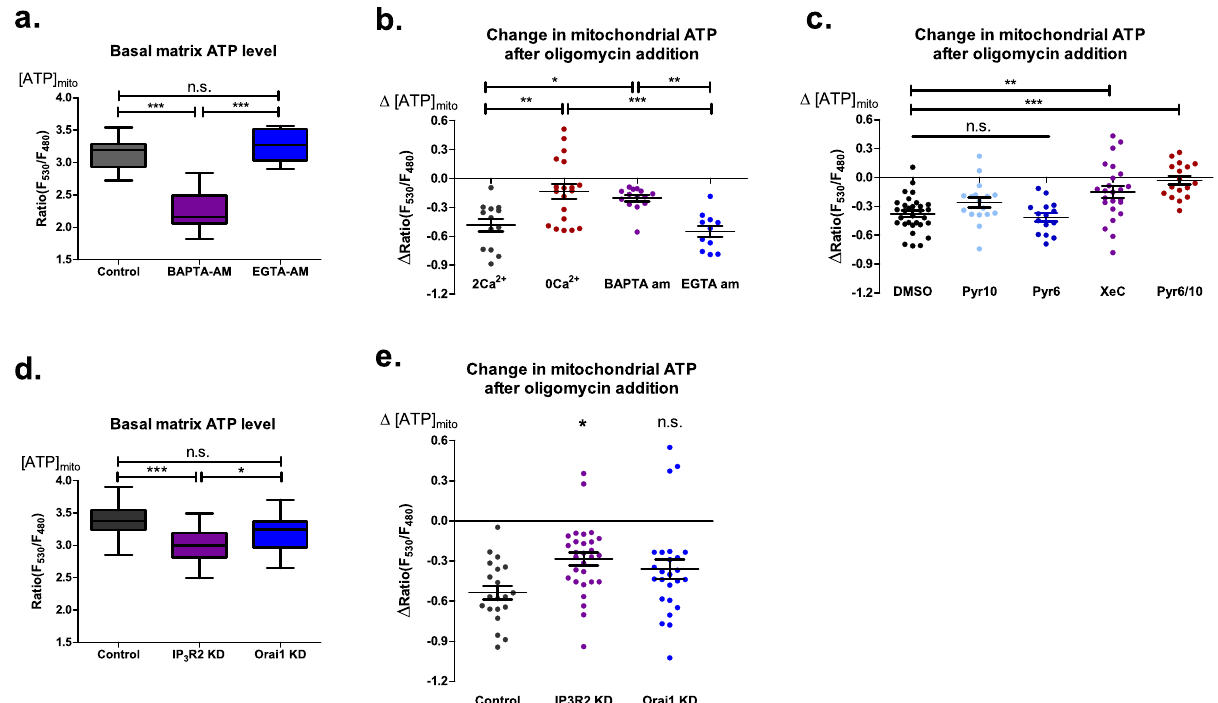
Fig. 8 Mitochondrial bioenergetics are in fl uenced by basal MAM Ca 2 + fl ux. a Basal matrix ATP levels in control cells and cells incubated with 50 µ M BAPTA-AM or 50 µ M EGTA-AM for 30 min (One-Way ANOVA with Tukey ’ s multiple comparison test, *** p < 0.001, n = 32 for control, n = 14 for BAPTA- AM, n = 11 for EGTA-AM). b Analysis of mitochondrial ATP change after 2 µ M oligomycin addition to cells perfused with 2 Ca 2 + or 0 Ca 2 + , and pre- incubated with 50 µ M BAPTA-AM or 50 µ M EGTA-AM (One-Way ANOVA with Tukey ’ s multiple comparison test, * p < 0.05, ** p < 0.01, *** p < 0.001, n = 13 for 2 Ca 2 + , n = 19 for 0 Ca 2 + , n = 14 for BAPTA-AM, n = 11 for EGTA-AM). c Analysis of mitochondrial ATP change after 2 µ M oligomycin addition to cells incubated with DMSO control ( n = 31), 3 µ M Pyr6 ( n = 17), 3 µ M Pyr10 ( n = 15), 10 µ M XeC ( n = 24), and 3 µ M Pyr6/3 µ M Pyr10 ( n = 17), One- Way ANOVA with Tukey ’ s multiple comparison test, ** p < 0.01, *** p < 0.001. d Basal matrix ATP levels in control, IP 3 R2 KD and Orai1 KD cells (One-Way ANOVA with Tukey ’ s multiple comparison test, *** p < 0.001, * p < 0.05, n = 20 for control, n = 29 for IP 3 R2 KD, n = 25 for Orai1 KD). e Analysis of mitochondrial ATP change after 2 µ M oligomycin addition to control, IP 3 R2 KD and Orai1 KD cells (One-Way ANOVA with Tukey ’ s multiple comparison test, * p < 0.05 versus control, n = 20 for control, n = 29 for IP 3 R2 KD, n = 25 for Orai1